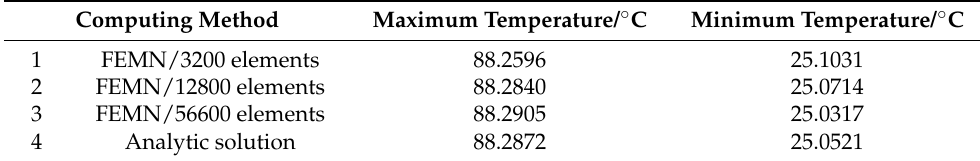
Figure 8. Grid refinement for the steady-state problem of uniform internal heat source (( a ) mesh number (3200), ( b ) mesh number (13,800), and ( c ) mesh number (56,600)). Table 3. Comparison of the upper and lower limits of the temperature